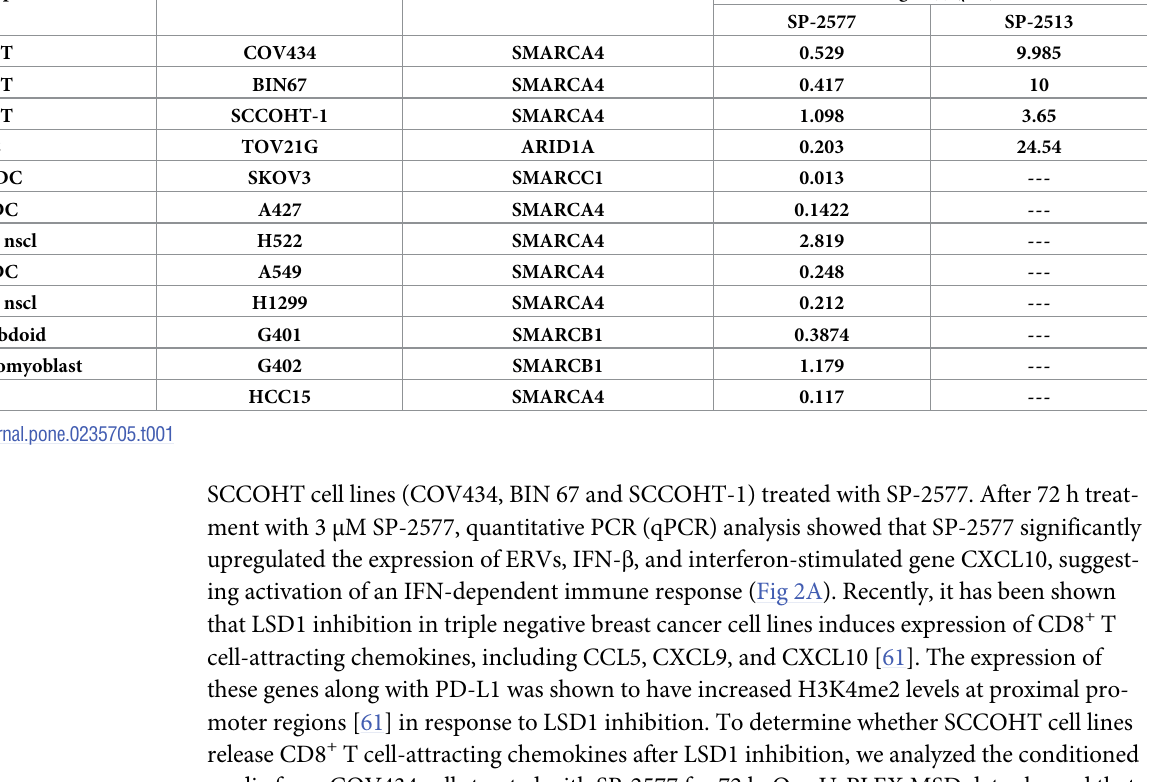
Table 1: Viability assay